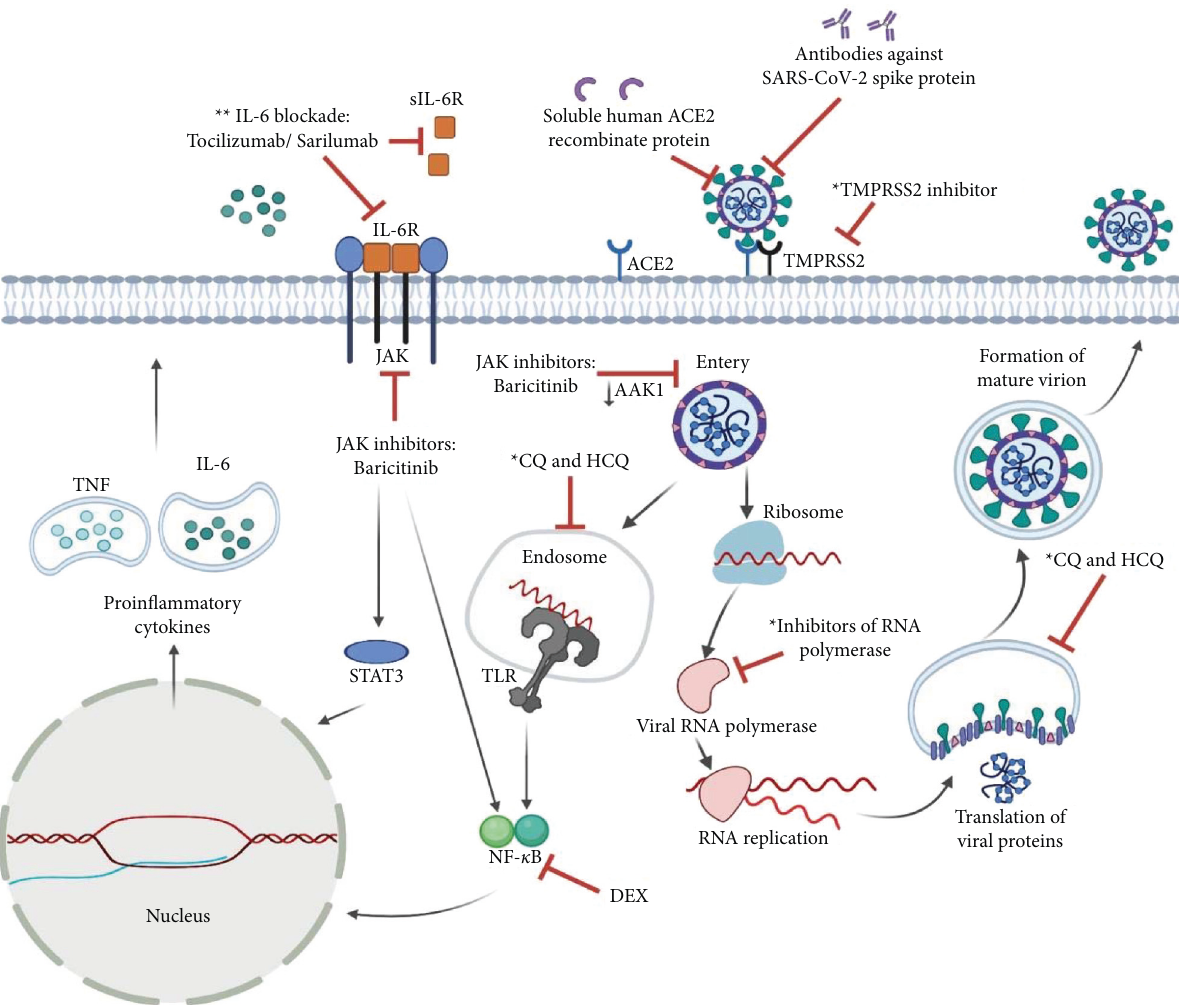
Figure 1: An illustration of the proposed therapeutic targets for the treatment of SARS-COV-2 infections. Angiotensin-converting enzyme- 2 (ACE2); AP2-associated protein kinase 1 (AAK1); chloroquine (CQ); dexamethasone (DEX); hydroxychloroquine (HCQ); interleukin (IL-); Janus kinase (JAK); nuclear factor- κ B (NF- (cid:0) B); signal transducer and activator of transcription 3 (STAT3); soluble IL-6 receptor (sIL-6R); transmembrane serine protease-2 (TMPRSS2); toll-like receptor (TLR); tumor necrosis factor (TNF). Some of the potential therapeutic targets of COVID-19 have been tested in vitro ( ∗ ) and in vivo ( ∗∗ ). The figure is created with BioRender